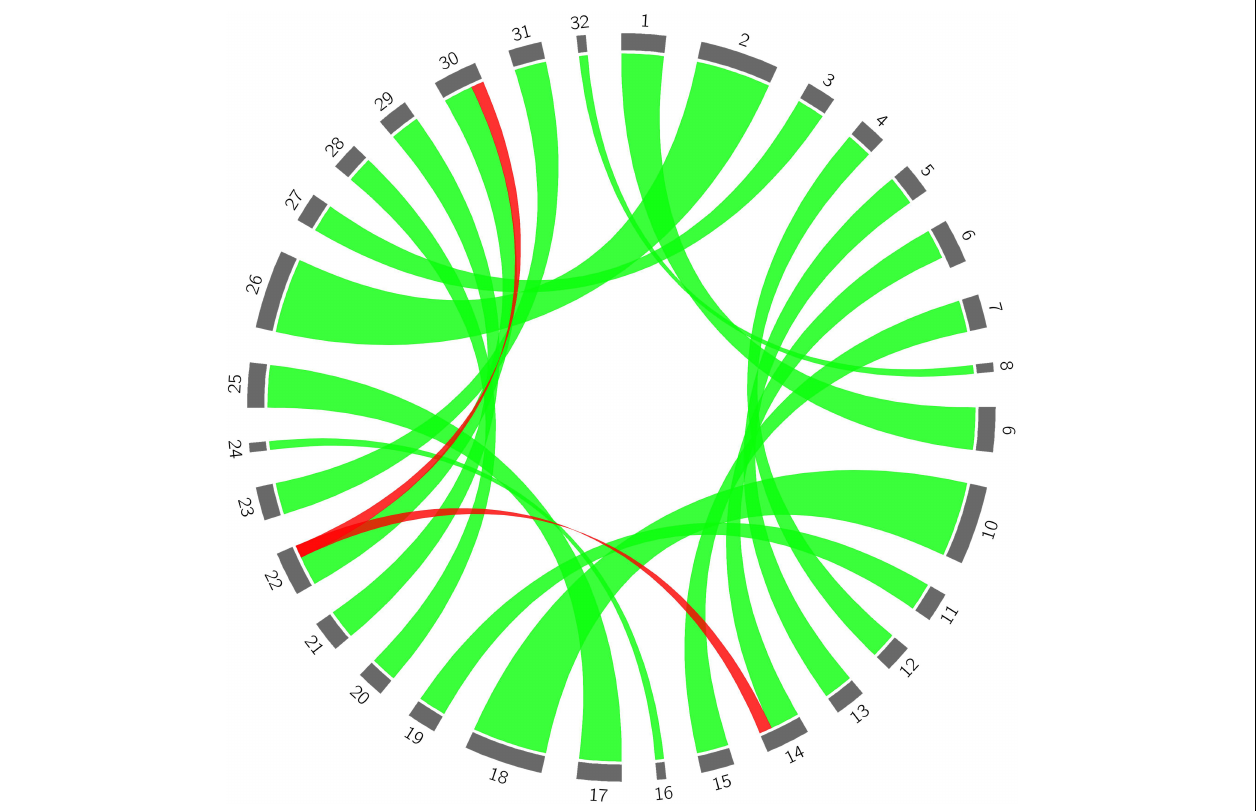
FIGURE 3 | The origin of genetic variance of the bud sport mutant compared to wild flat peach. 1–8 represent haplotypes of each chromosome in the wild flat peach genome, respectively; 9–16 represent haplotypes of each chromosome in the bud sport genome; 17–24 represent haplotypes of each chromosome in wild flat peach; 25–32 represent the haplotypes of each chromosome in the bud sport mutant, respectively. Green lines represent normal genetic transfer from wild flat peach to the bud sport mutant and red lines represent the relationship between the distal end of scaffold Pp06 between the wild-type and bud sport